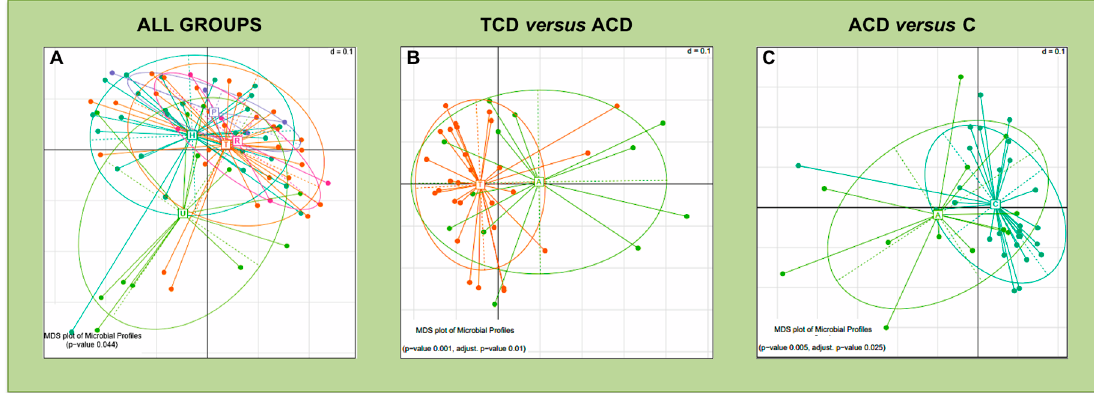
Figure 4. Beta-diversity comparison for the mucosal microbiota: Multidimensional Scaling (MDS) plots of mucosal samples for which the Permutational Multivariate Analysis of Variance test detected a significant separation of study groups in terms of bacterial community composition. The microbiota phylogenetic distances were evaluated through the generalized UniFrac distance. Each point represents the microbiota composition of one sample. Panel ( A ): all patient groups were compared. Panel ( B ): TCD versus ACD comparison. Panel ( C ): ACD versus C comparison. Each point represents the microbiota composition of one sample.